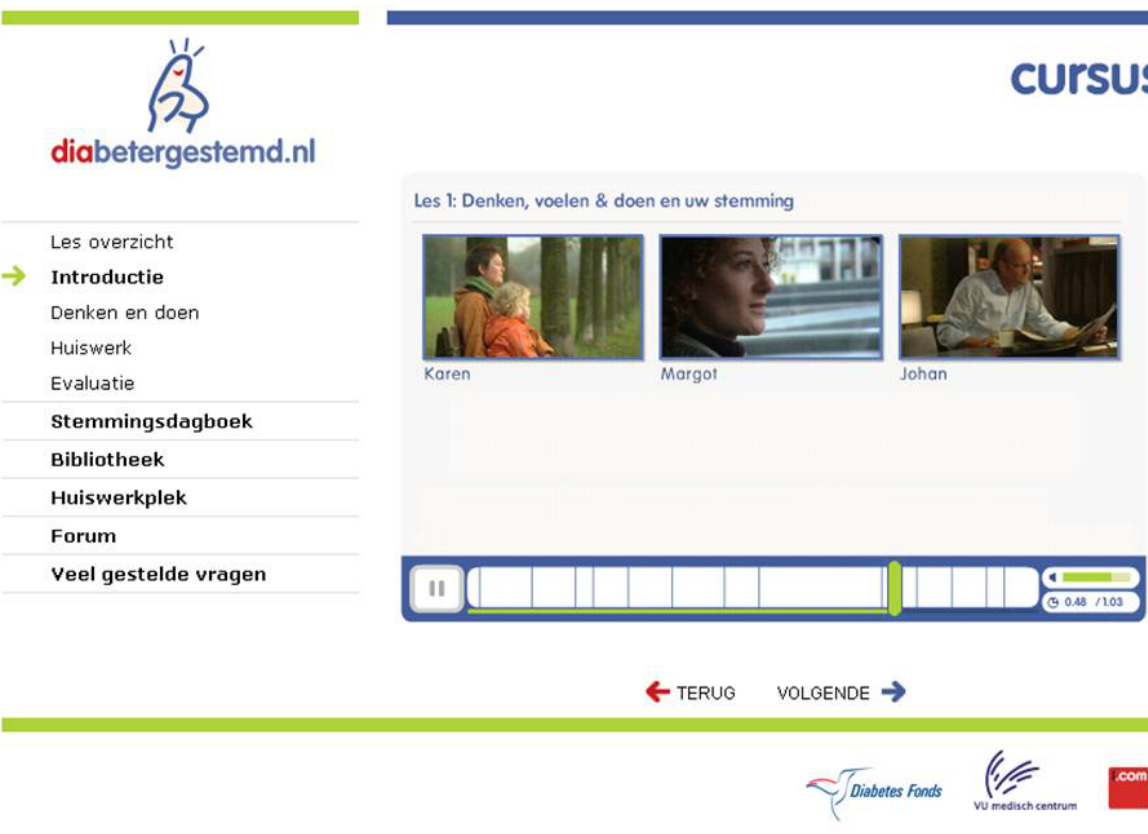
Figure 2. Screenshot of a lesson in the web-based diabetes-specific